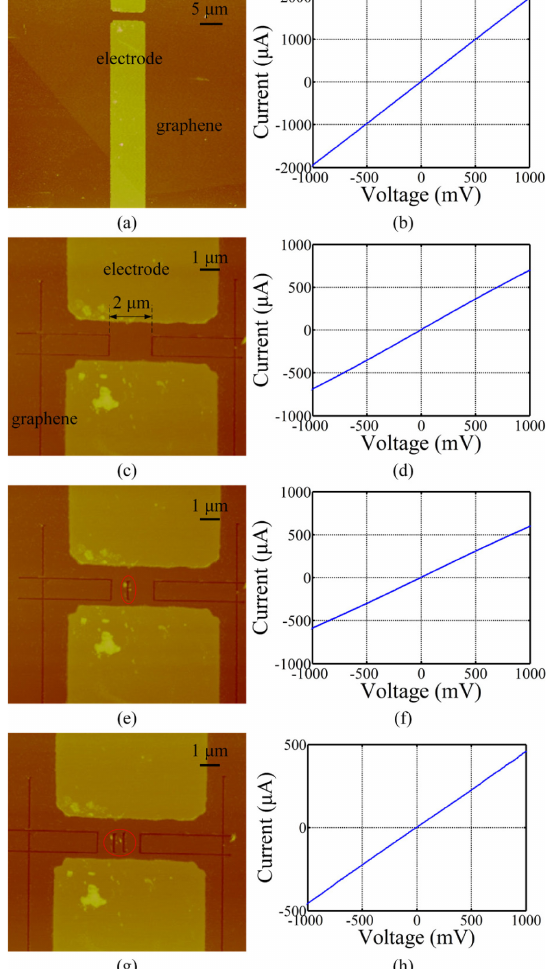
Figure 6. Electrical characterization of graphene with and without line defects. ( a ) AFM image of graphene before defects are induced; ( b ) I-V curve before defects are induced; ( c ) AFM image of 2 µ m wide graphene ribbon; ( d ) I-V curve of 2 µ m wide graphene ribbon. ( e ) AFM image of graphene after first defect is induced in the graphene ribbon. The red ellipse indicates the location of the defect; ( f ) I-V curve after first defect is induced in the graphene ribbon; ( g ) AFM image of graphene after second defect is induced; and ( h ) I-V curve after second defect is induced.